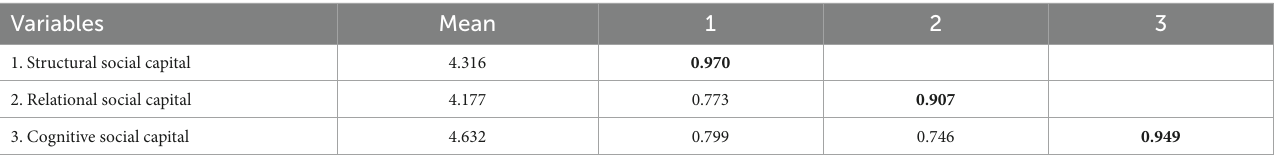
TABLE 4 Results for validity and descriptive statistics.